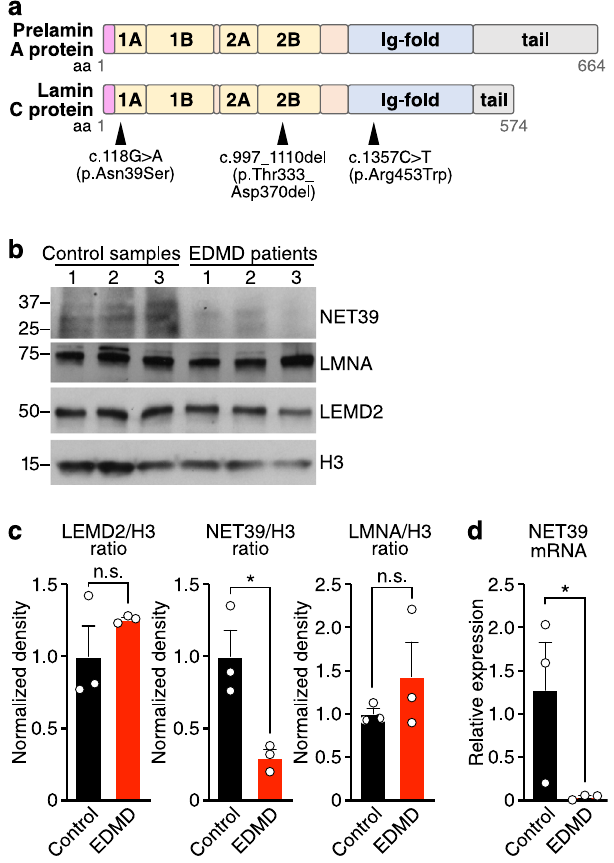
Fig. 4 Net39 is downregulated in EDMD. a Illustration of Lamin A/C protein domains highlighting speci fi c mutations in three Emery – Dreifuss muscular dystrophy (EDMD) patients. In the Lamin A/C protein domains, pink indicates head region, yellow denotes rod domains, blue shows Ig fold, and gray indicates the tail regions of Lamin C and pre-Lamin A. b Western blot analysis of human muscle biopsies from healthy (control) individuals and EDMD patients showing NET39, LMNA, and LEMD2 protein expression. Histone H3 (H3) was used as a nuclear loading control. c Densitometry of western blots shown in b was performed and the ratios of LEMD2/H3 ( p = 0.2903) (left), NET39/H3 (middle) (* indicates p = 0.0199), and LMNA/H3 (right) ( p = 0.3454) were quanti fi ed. n = 3 biologically independent samples. Data are presented as mean±SEM values. Statistical comparisons between groups were evaluated by unpaired and two-sided Student ’ s t test. d qRT-PCR analysis of Net39 transcript in control and EDMD patient biopsy samples. Net39 mRNA expression in patient samples is normalized to its expression in control samples. * indicates p = 0.0445. n = 3 biologically independent samples. Data are presented as mean±SEM values. Statistical comparisons between groups were evaluated by unpaired, one-tailed Student ’ s t test. Source data are provided as a Source data fi le.